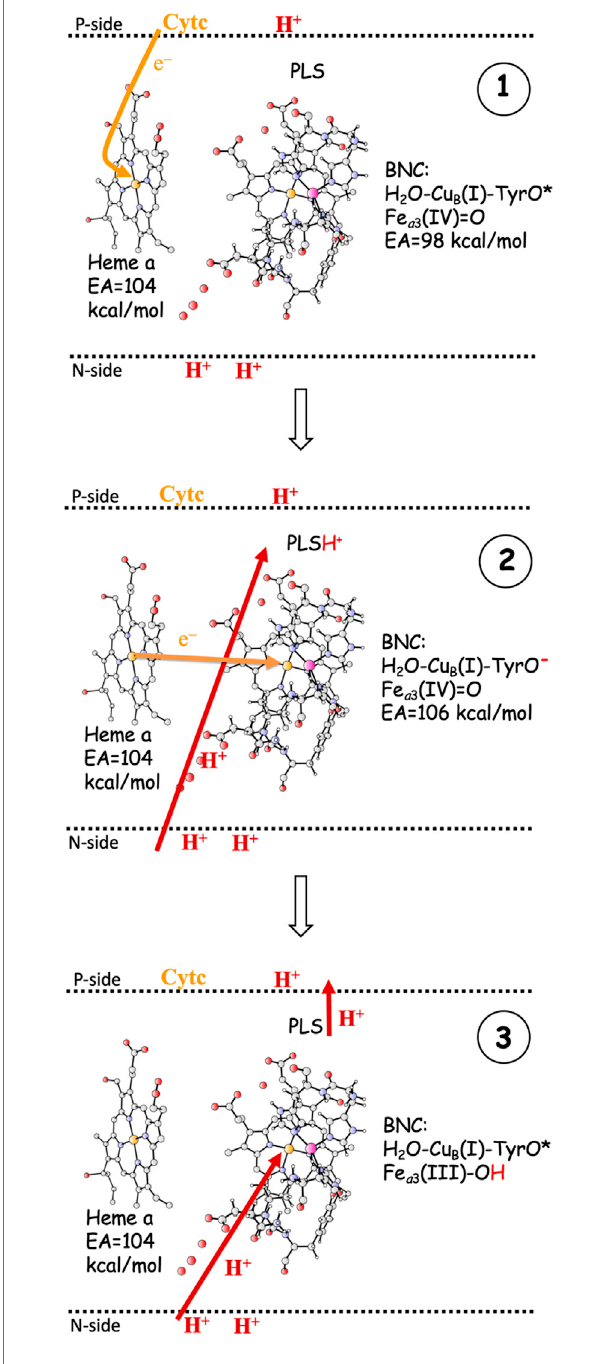
FIGURE3| Onereductionstep,scetchingthemainstepsinacommonly accepted scheme for proton pumping in C c O (Wikström et al., 2018). 1 . Electrontransferfromsolublecytochrome c tothelow-spinheme a .TheEAof the BNC is too low for the electron to move further into the BNC. 2 . The electron in heme a triggers proton uptake from the N-side to PLS, which increases the EA of the BNC, such that the electron can move from heme a into the BNC. 3 . The electron in the BNC triggers the uptake of the chemical proton from the N-side to the BNC, and the proton in the BNC repels the proton in the PLS, which is ejected to the P-side. - The F to O H reduction is used as an example.